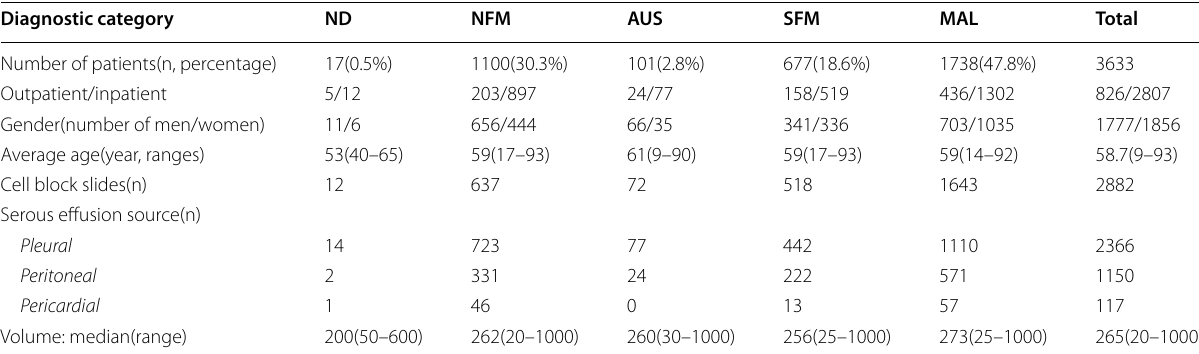
Table 1 Patient demographics and specimen characteristics of 3633 serous effusions based on each TIS category